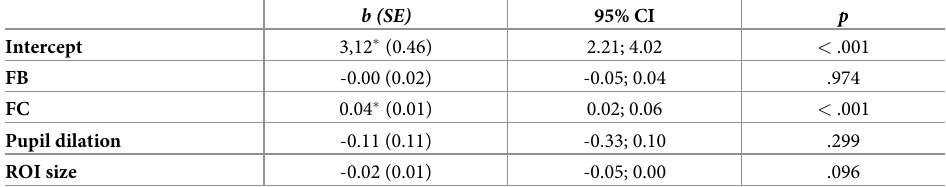
Table 4. Prediction of moral maturity by FB, FC and pupil dilation when controlling for ROI size using linear mixed